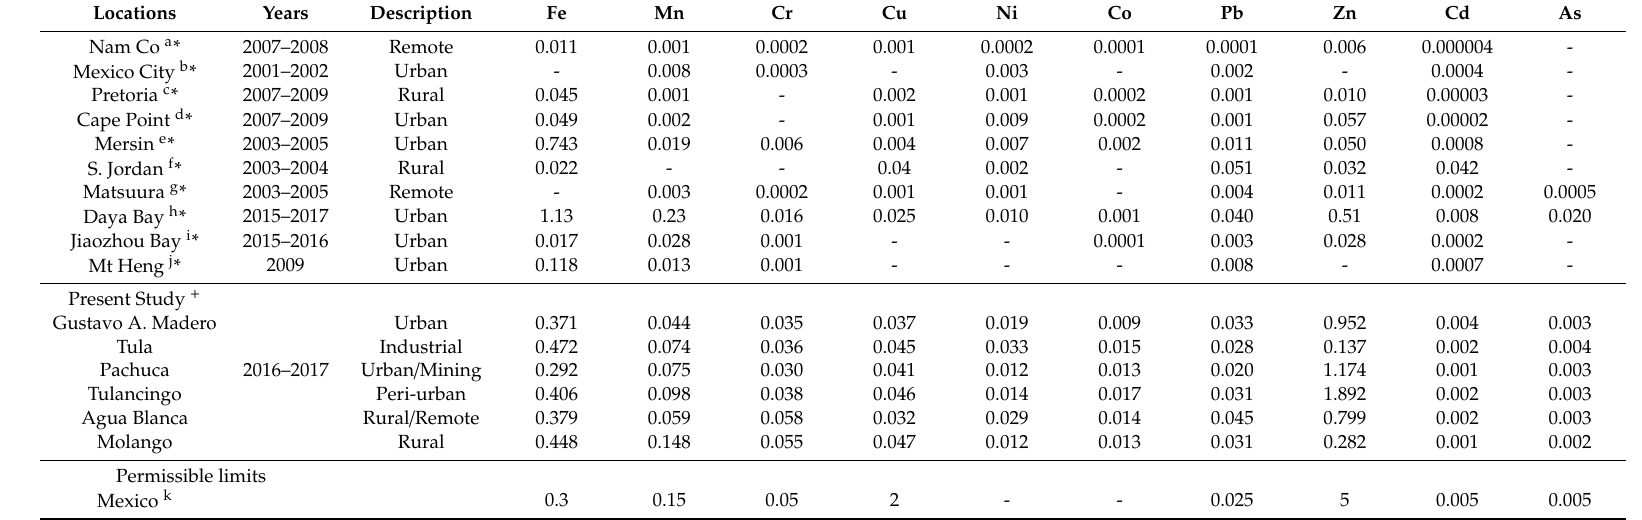
Table 2. Comparison of the trace element concentrations (mg / L) with the data reported from various locations around the world.